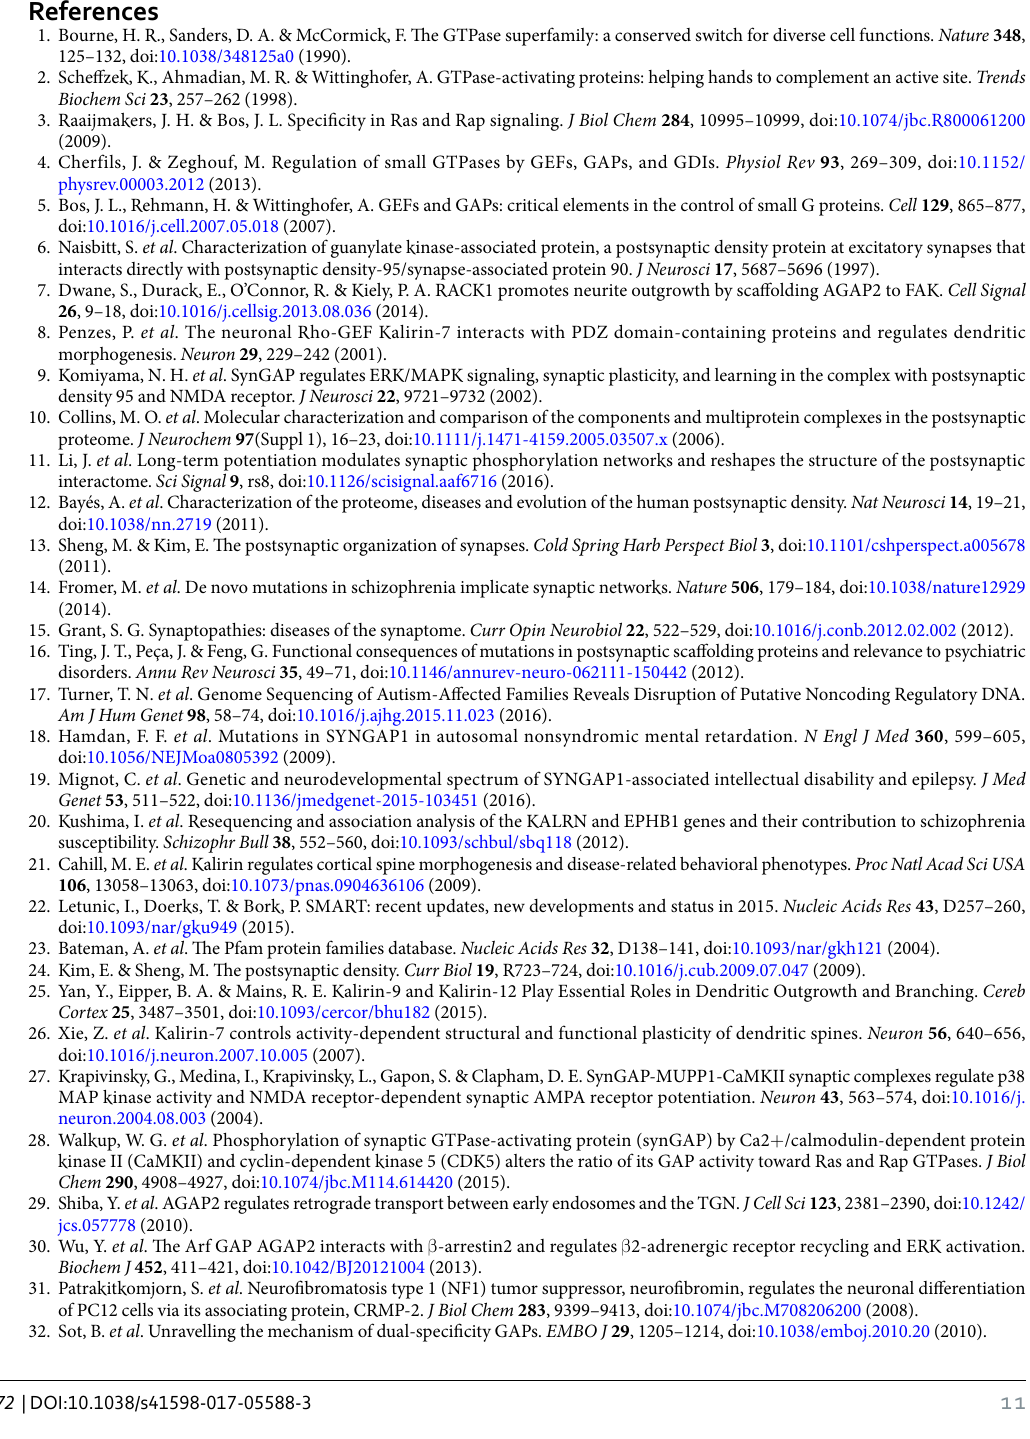
included: (1) Supplementary Table 15 from Turner et al . 17 which encompasses a list of 57 genes found to have recurrent de novo likely gene disrupting (LGD) mutations in probands with autism from a collection of exome sequencing studies 43, 45 , (2) Supplementary Table 7 from Iossifov et al . 43 which contains 353 genes harboring vali- dated de novo LGD mutations in probands with autism, (3) Supplementary Table 3 from De Rubeis et al . 45 which included 107 genes with an FDR < 0.3 implicated in contributing to autism through the TADA statistical model, 4) SFARI gene database 44 as of February 2016 which was restricted genes containing the SFARI gene rankings 1 – 4 (strong evidence to minimal evidence) and S (syndromic) (5) Supplementary Table 5 from Fromer et al . 14 which contains de novo SNVs identified in probands with SCZ excluding silent mutations, (6) Supplementary Table 3 from Ripke et al . 55 restricted to loci reaching genome wide significance in patients with SCZ and implicating a single gene, (7) Supplementary Table 4 from Leliveld et al . 56 which contains a list of 1537 genes known to contrib- ute to ID. For all tests, protein coding genes expressed in purified mouse cortical neurons derived from Zhang et al . 54 served as the background measured by one-tailed Fisher’s exact test with the option “greater,” followed by the Bonferroni correction for multiple comparisons using the (fisher.test) and (p.adjust) packages in R,